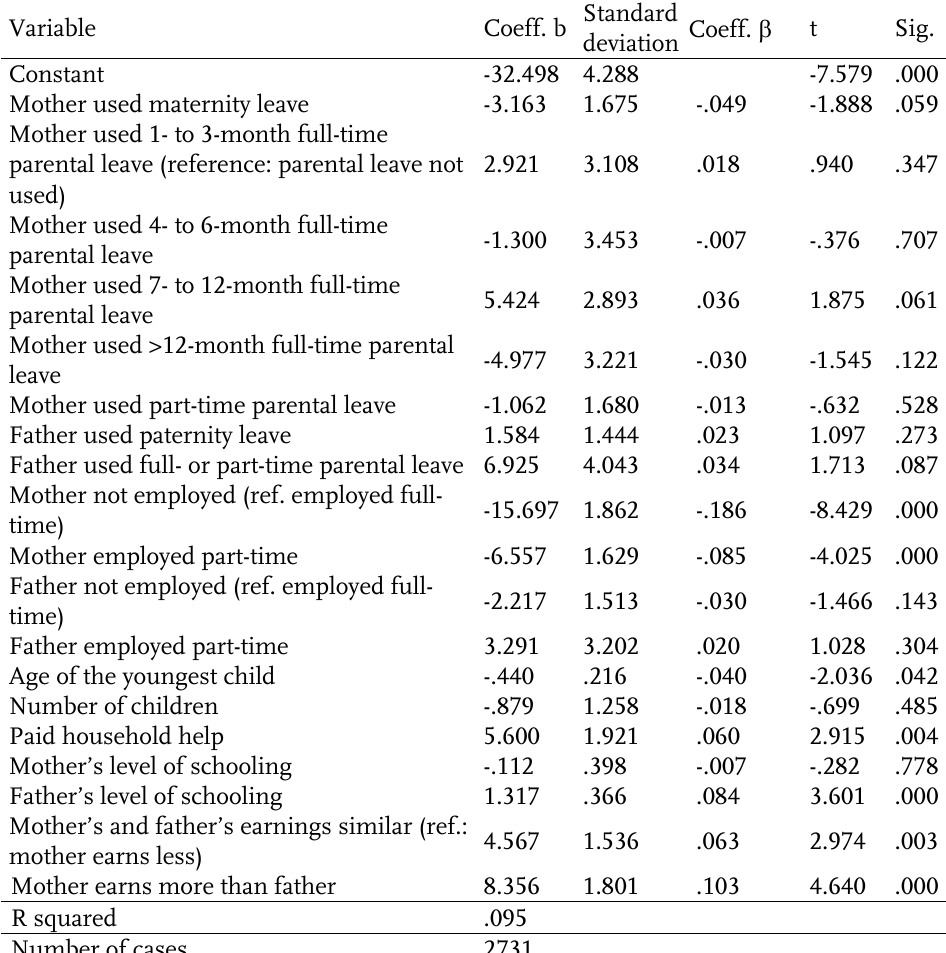
Table 3 : Factors conditioning gender inequality in the distribution of housework between partners Variable Coeff. b